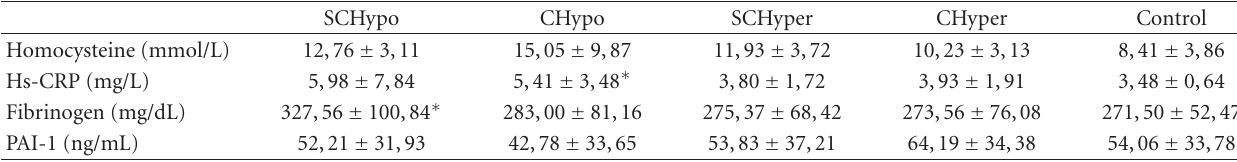
Table 2: Homocysteine, hs-CRP, Fibrinogen, and PAI-1 levels in Thyroidism groups.